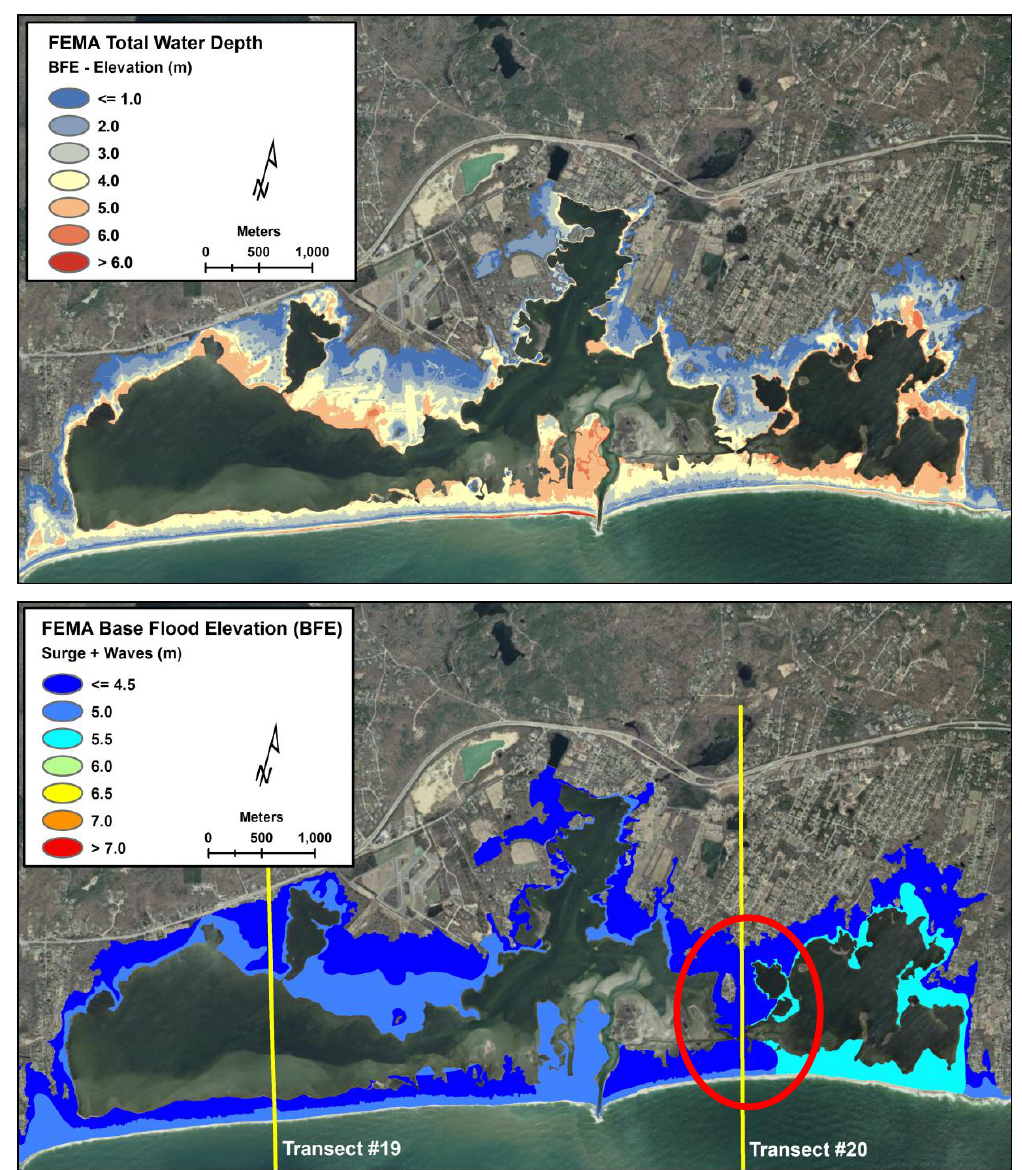
Figure 12. FEMA predicted total water depth (m) measured from grade to Base Flood Elevation (BFE) ( upper panel ) and BFE (m) relative to NAVD88 ( lower panel ). FEMA transect lines are shown in yellow, #19 (left) and #20 (right). Area of substantial increase in BFE near the shoreline from one side of transect #20 to the other (red